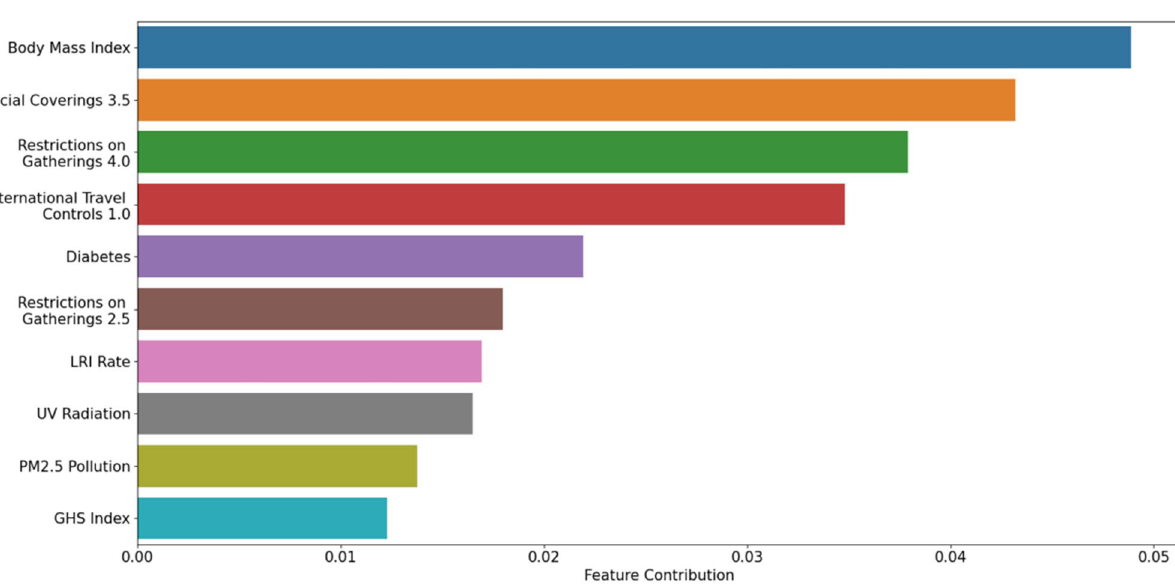
Figure 4. Features importance (Top 10): (i) body mass index, (ii) the number of days that the government sets restrictions on requiring facial coverings outside the home at all times, (iii) restrictions on gatherings 4.0, (iv) screened foreign travelers on international travel, (v) diabetes prevalence, (vi) restrictions on gatherings 2.5, (vii) LRI rate, (viii) UV radiation, (ix) PM2.5 air pollution, and (x) GHS